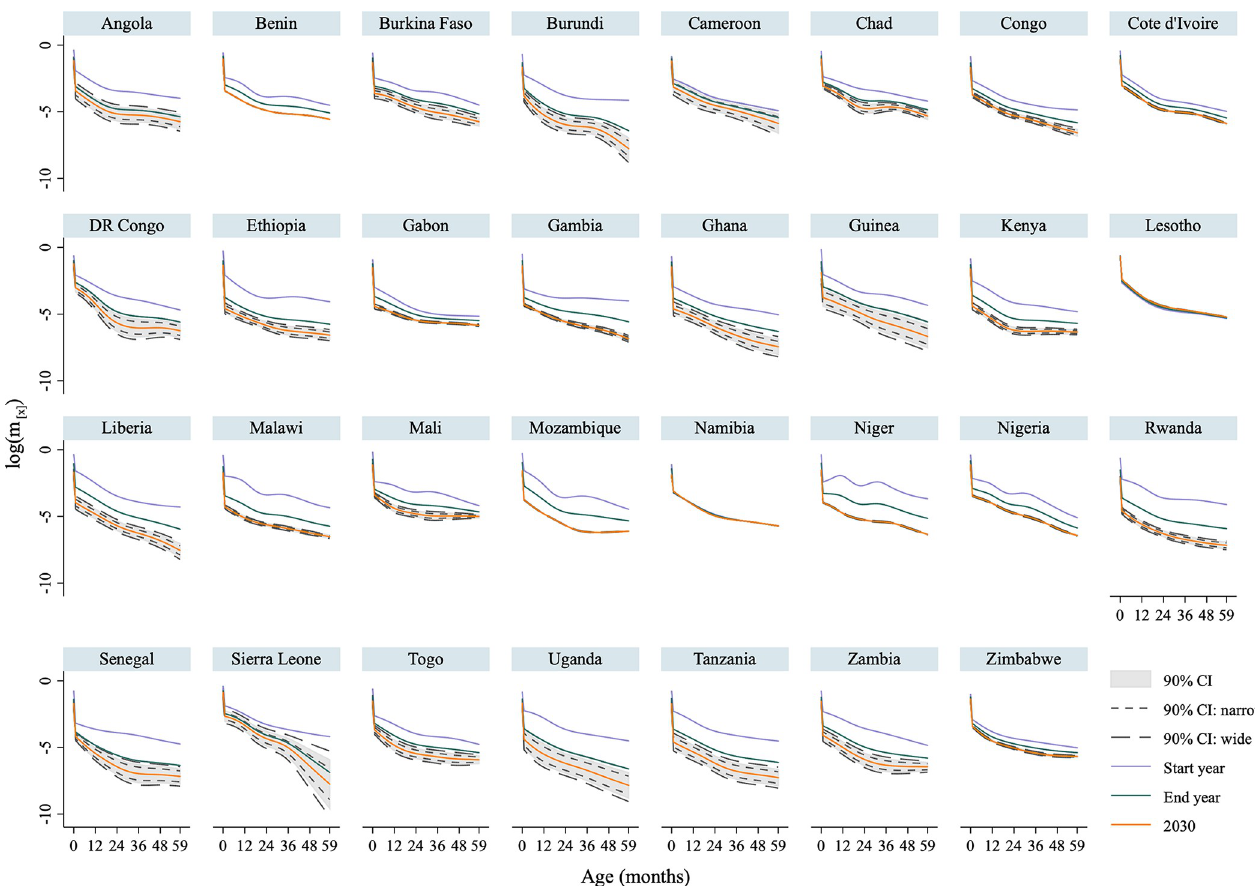
Fig 2. LLT fit and prediction of age patterns of death rates for under-5 children in 31 SSA countries. Author’s estimates using the LLT model [43] with data from the DHS program. CI, credible interval; DHS, Demographic and Health Survey; LLT, Li–Lee–Tuljapurkar; SSA, sub-Saharan